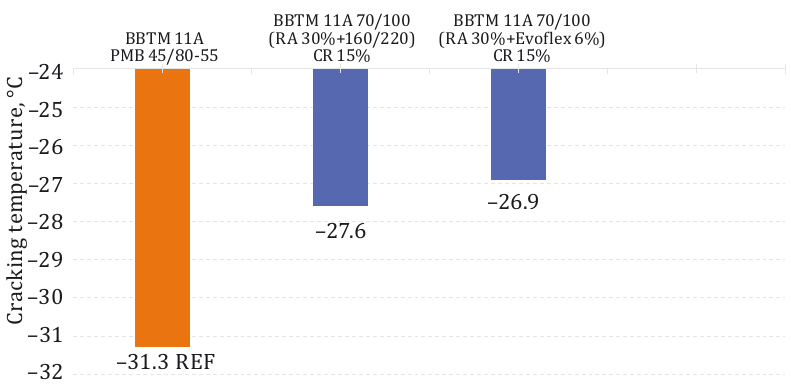
Figure 4. Low-temperature cracking performance results for the